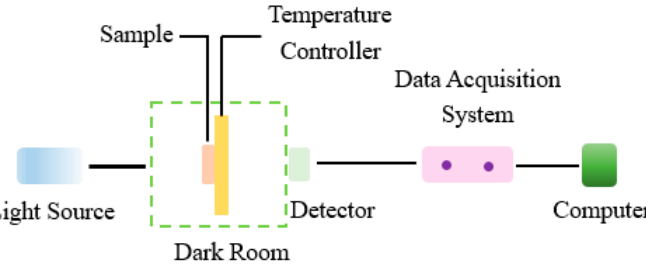
Figure 1. Schematic diagram of the transmittance measurement system.